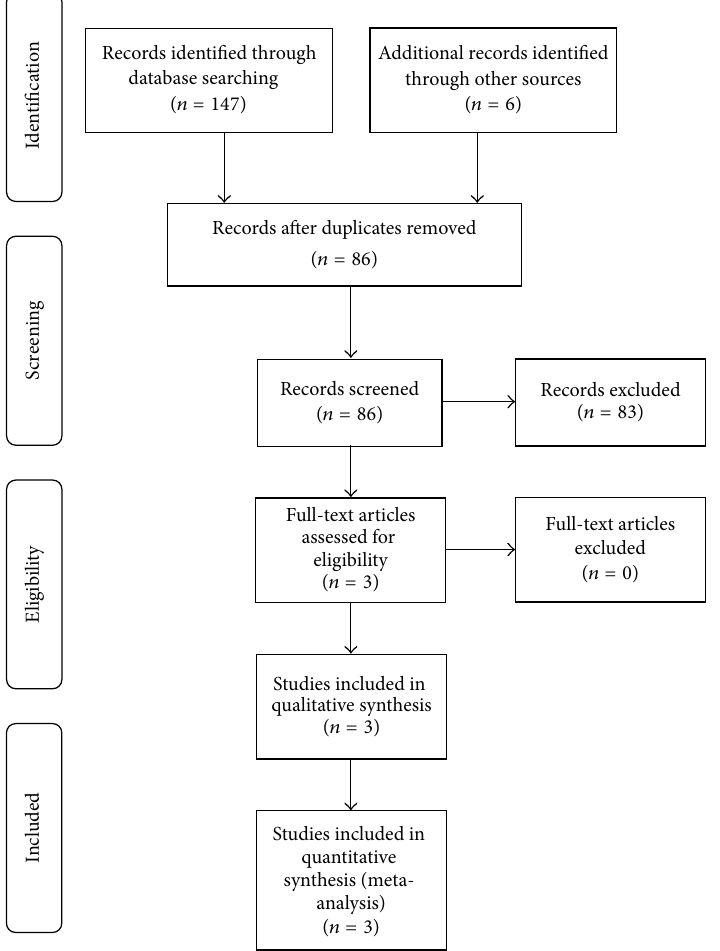
Figure 1: Systemic review algorithm using PRISMA